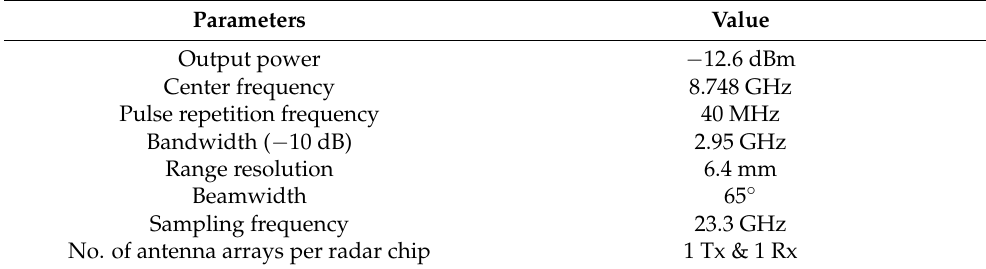
Table 1. Radar module parameters.